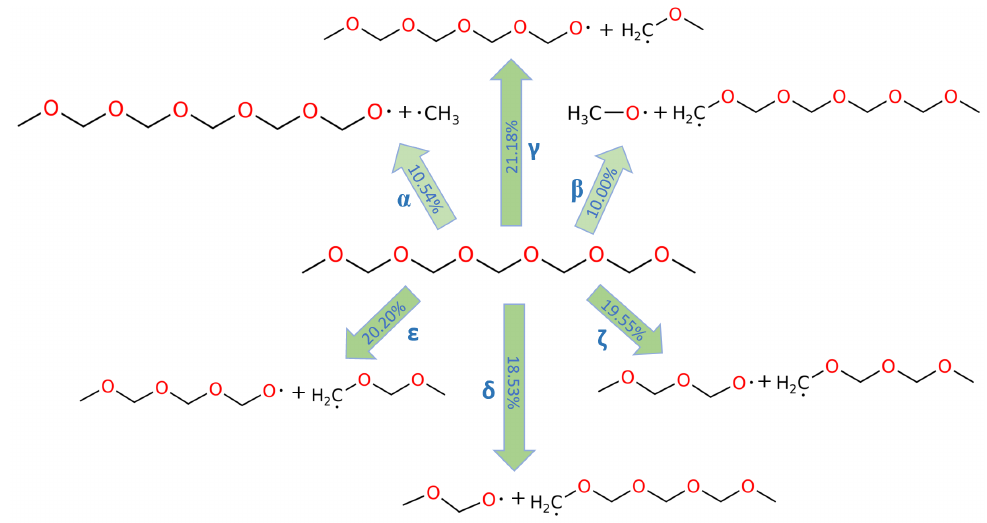
Figure 3. C ‐ O bond dissociation in PODE4 at 3000 K.